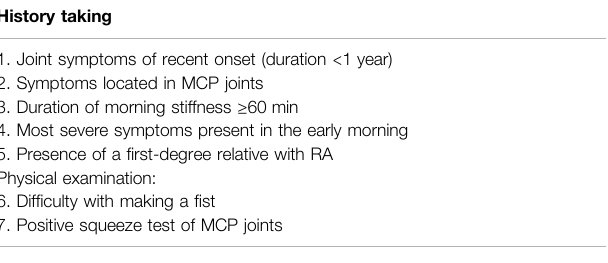
TABLE 1 | EULAR de fi ned characteristics describing arthralgia at risk for RA (adapted from van Steenbergen et al., 2017). History taking